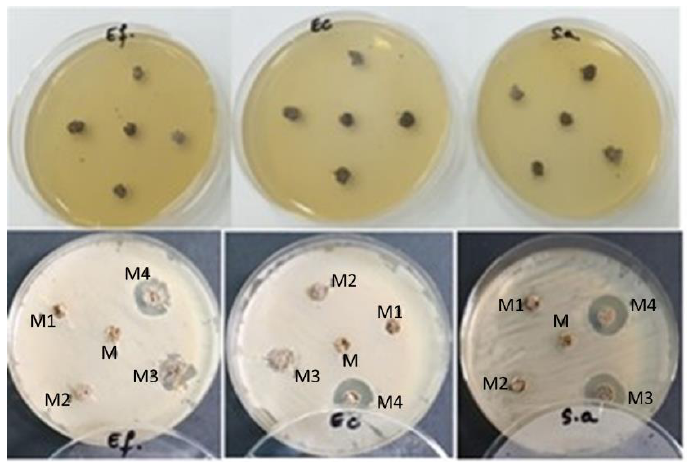
Figure 3. Application of the bacterial strains ( Ef. Ec. Sa .) on the five tested mortar samples at the time 0 (initially) and after 24 h. Table 4. Diameter of inhibition zones (mm) of the tested mortar samples.